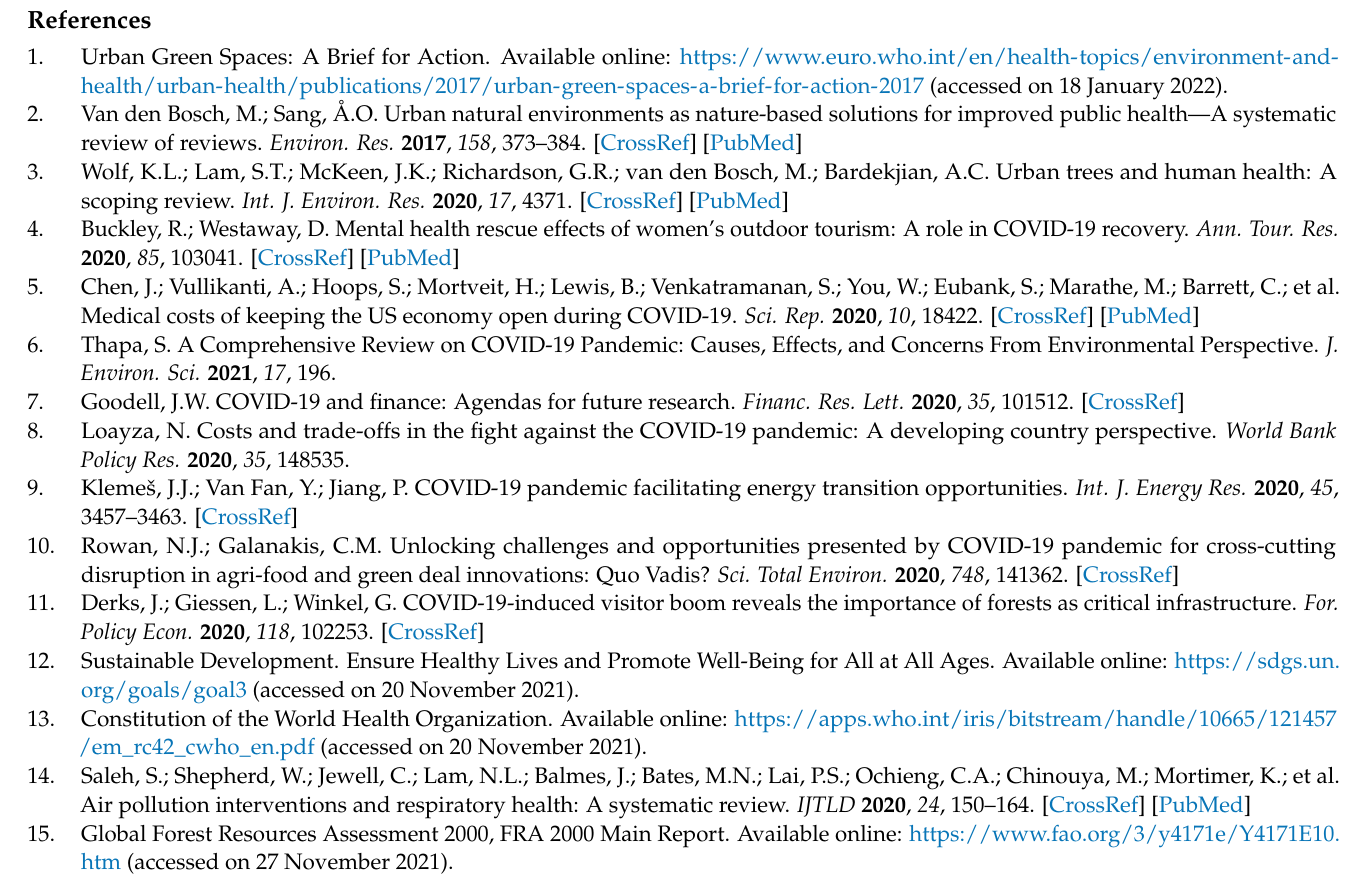
Figure A4. Internal Consistency of Information Supplied by Models P1, P2 and P3. Best 30 munici- palities. (Source: